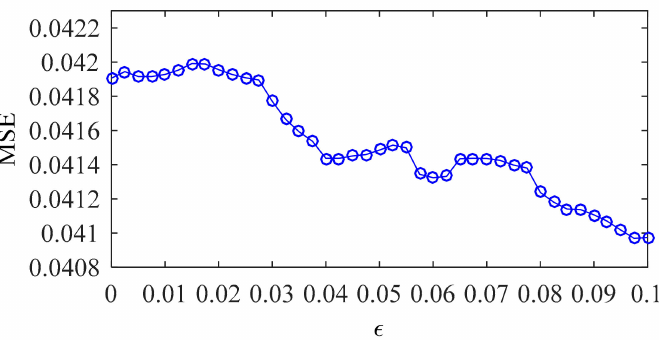
Figure 11. Iterative optimization process of GSM.